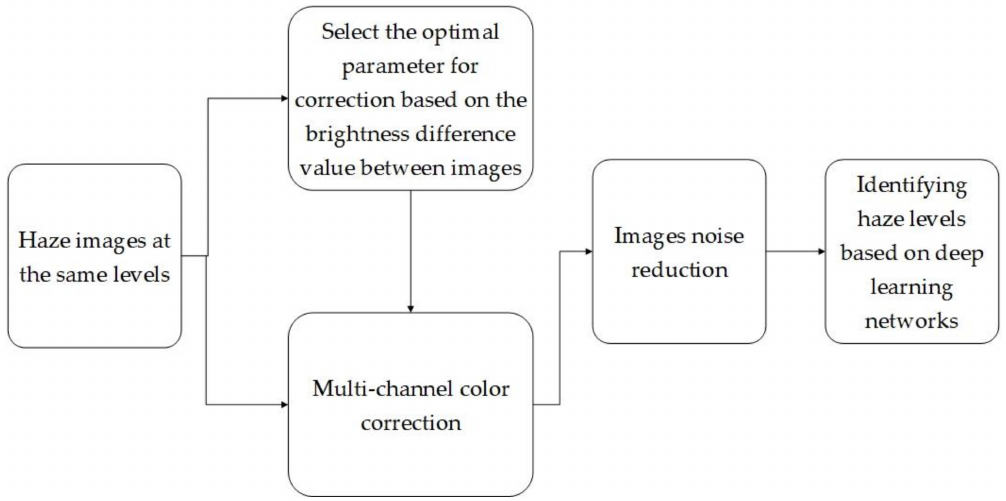
Figure 1. Implementation steps of this